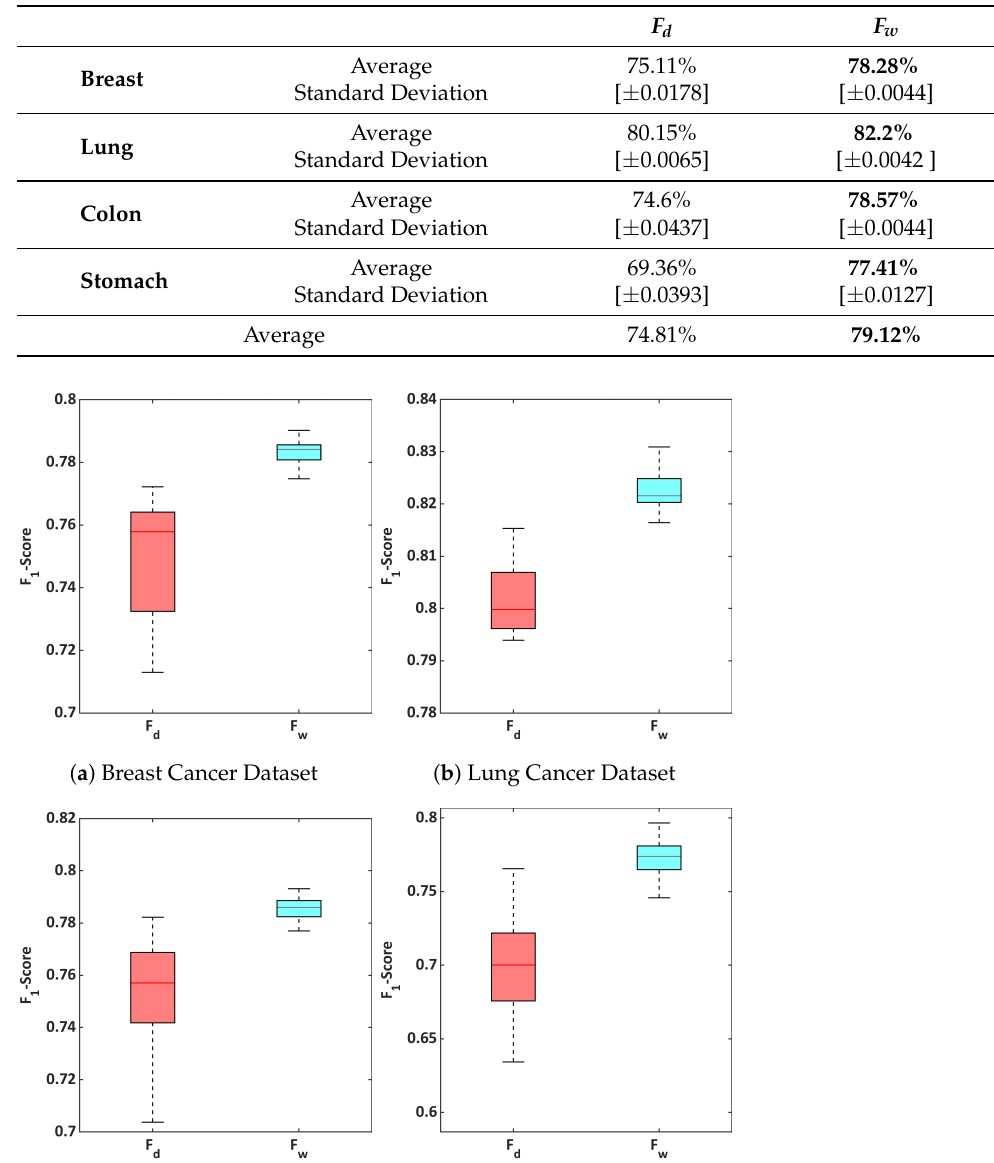
Table 5. F 1 -Score results obtained by F d and F w .